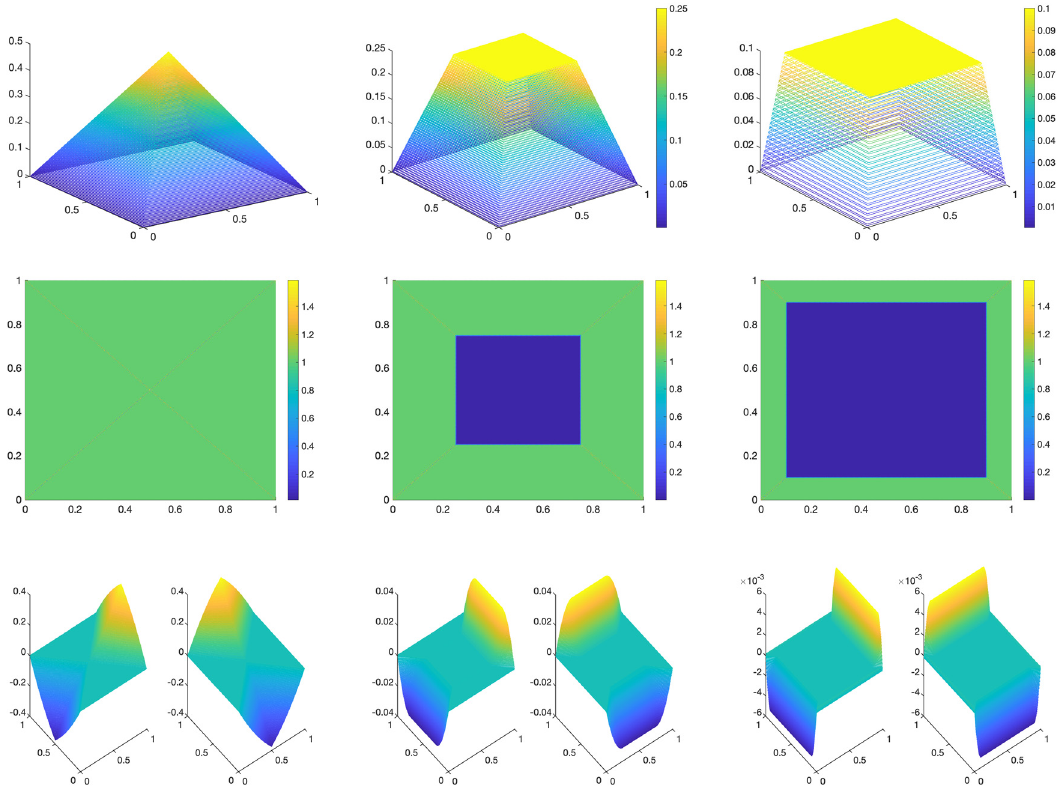
Figure 3: Example 1 ( fi xed α , varying f ) . The rows correspond to u h , ∣ ∣ u h 2 ∇ , and p